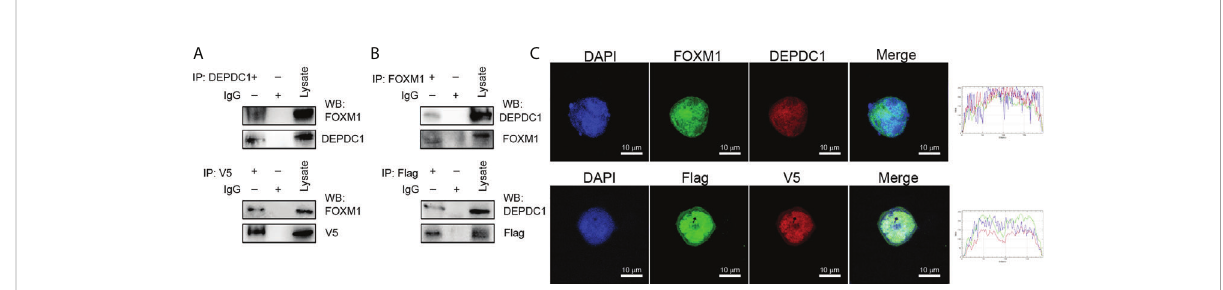
FIGURE 3 DEPDC1 associates with FOXM1. (A) FOXM1-expressing plasmids tagged with FLAG and DEPDC1 plasmids with V5 tags were both transfected into HEK293 T cells. Co-immunoprecipitation of transfected cell lysates using anti-V5 or anti-DEPDC1 antibodies bound to beads. Western blotting was then used to identify DEPDC1 is labelled with V5 using anti-V5 or anti-DEPDC1 antibodies. (B) Reverse immunoprecipitation. We transfected HEK293T cells with controls or FLAG-bound FOXM1 and V5-bound DEPDC1. Anti-V5 or anti-FOXM1 antibodies were used to Co- immunoprecipitate cell lysates. Anti-FLAG or anti-FOXM1 antibodies were used for Western blotting to detect immunoprecipitated products (C) . The subcellular sites of DEPDC1-V5 and FOXM1-Flag were transfected into SCC-25 cells. One day after transfection, cells were fi xed, penetrated and incubated with green FLAG, red V5, green FOXM1 and red DEPDC1 Confocal microscopy were performed to analyze nuclei stained with DAPI (blue). Graphs of the intensity pro fi le are shown at the bottom of the image (x-axis, length [in microns]; y-axis, intensity). The bar is set to scale: 10 µm. The data are representative of at least 3 independent experiments.